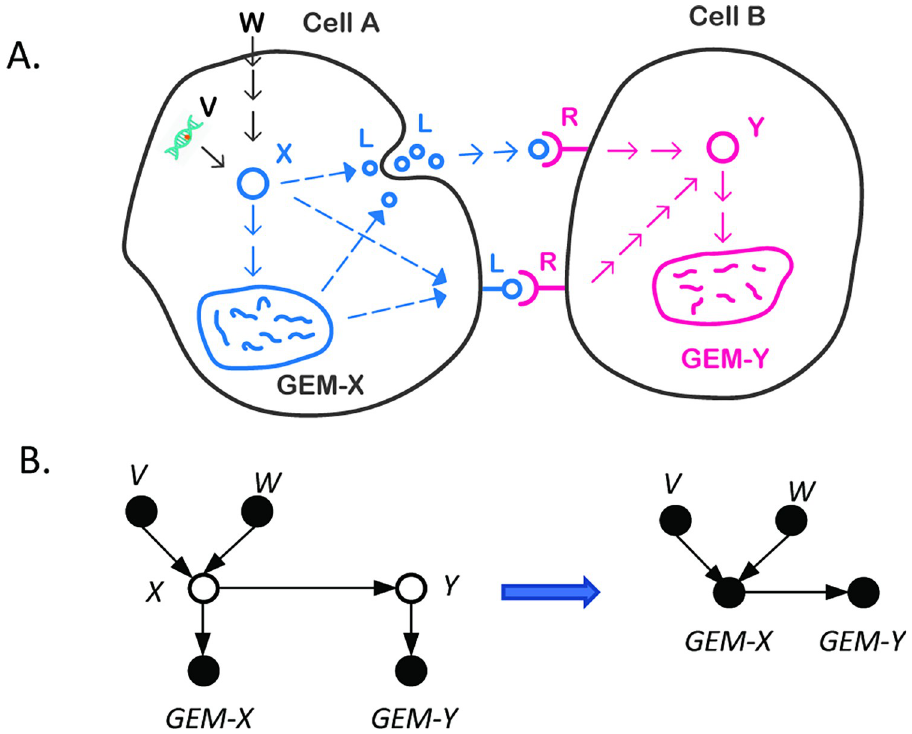
Fig 6. Causal modeling of an intercellular cellular communication network. A. A biological scenario to be modeled by our framework . The activation states of the pathway X in Cell A can be affected by physiological signal (e.g., an extracellular signal W) or genomic alteration (e.g., V). Activation of pathway X in Cell A may lead to release or cell-surface presentation of a ligand L, which may be produced through de novo transcription. Ligand-receptor interaction (LR) leads to activation of pathway Y in Cell B. Activation of X and Y may be deterministically associated with expression of corresponding GEMs. B. A Causal Bayesian network (CBN) for modeling the signal transduction depicted in A . The CBN on the left side explicitly represents the relationships of pathways X and Y, their upstream signals (V and W), and the GEMs regulated by them. In a CBN, observed variables are represented as filled nodes, and latent variables are represented as open nodes. In general, variables V and W can be any type of observed variable, including the expression values of GEMs reflecting the states of corresponding latent signaling pathways in other cells. Under the above assumption, we can use GEM-X and GEM-Y as proxies of latent variables X and Y, such that the causal edge between X and Y can be represented and estimated as a causal edge between GEM-X and GEM-Y as reported in this